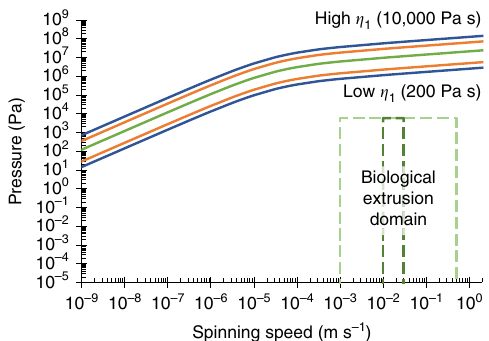
Fig. 6 The effect of viscosity variation on pressure requirements. The effect of varying the zero shear viscosity (across the range 400 – 5000Pa s 57 ( orange ), mean (1722 Pa s 58 , green ), and 200-10,000Pa s 58 ( blue )) on the